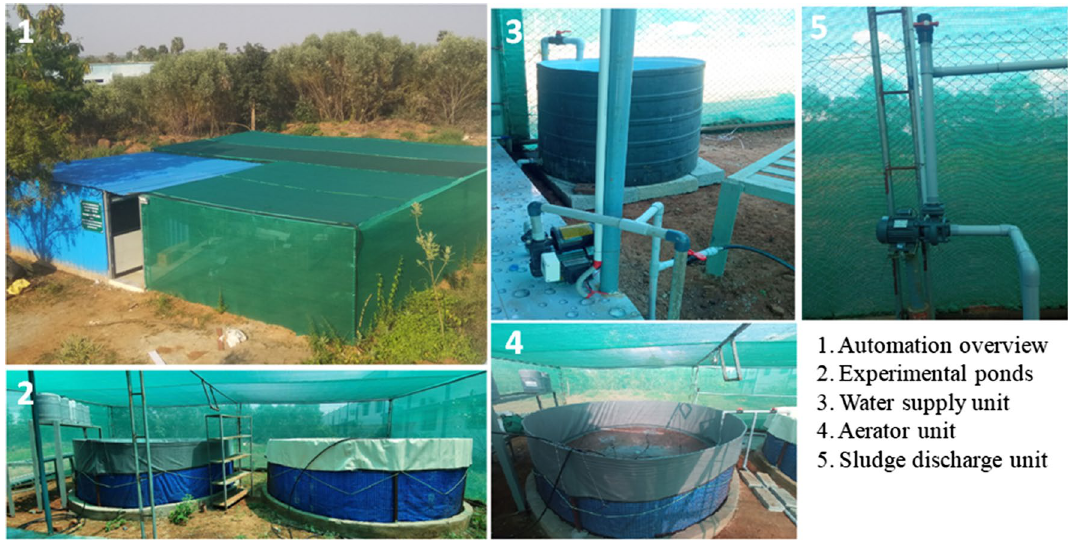
Fig. 2 depicts the overview of experimental aquaculture automation system for Biofloc production of shrimp (Place: Bharathidasan Univer- sity, Tiruchirappalli, India)